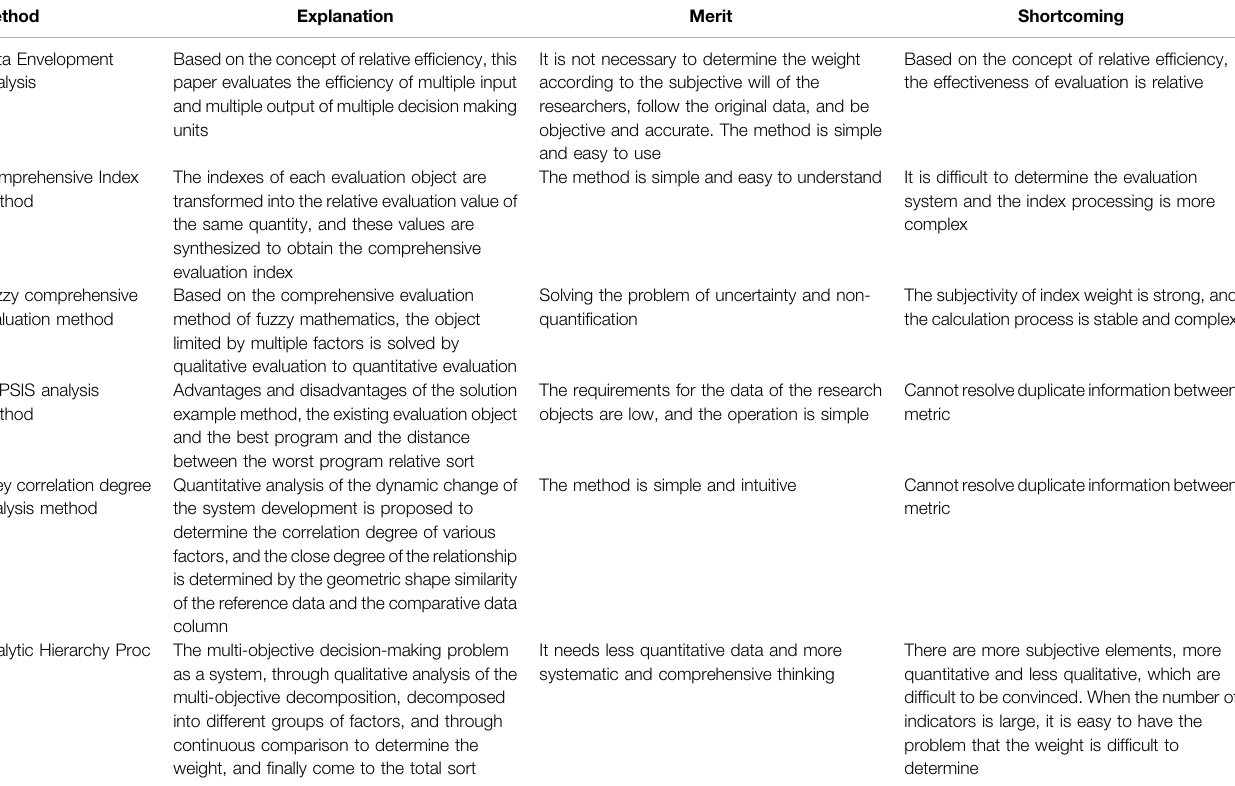
TABLE 1 | Comparison of evaluation and analysis